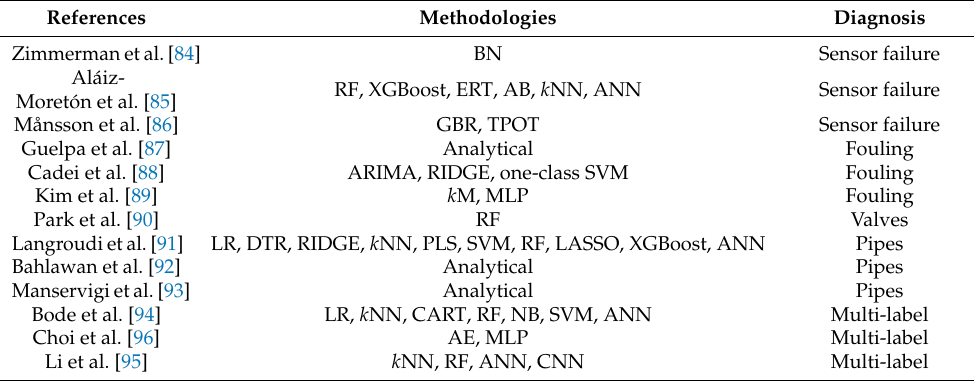
Table 6. Summary of applications of fault diagnosis approaches.